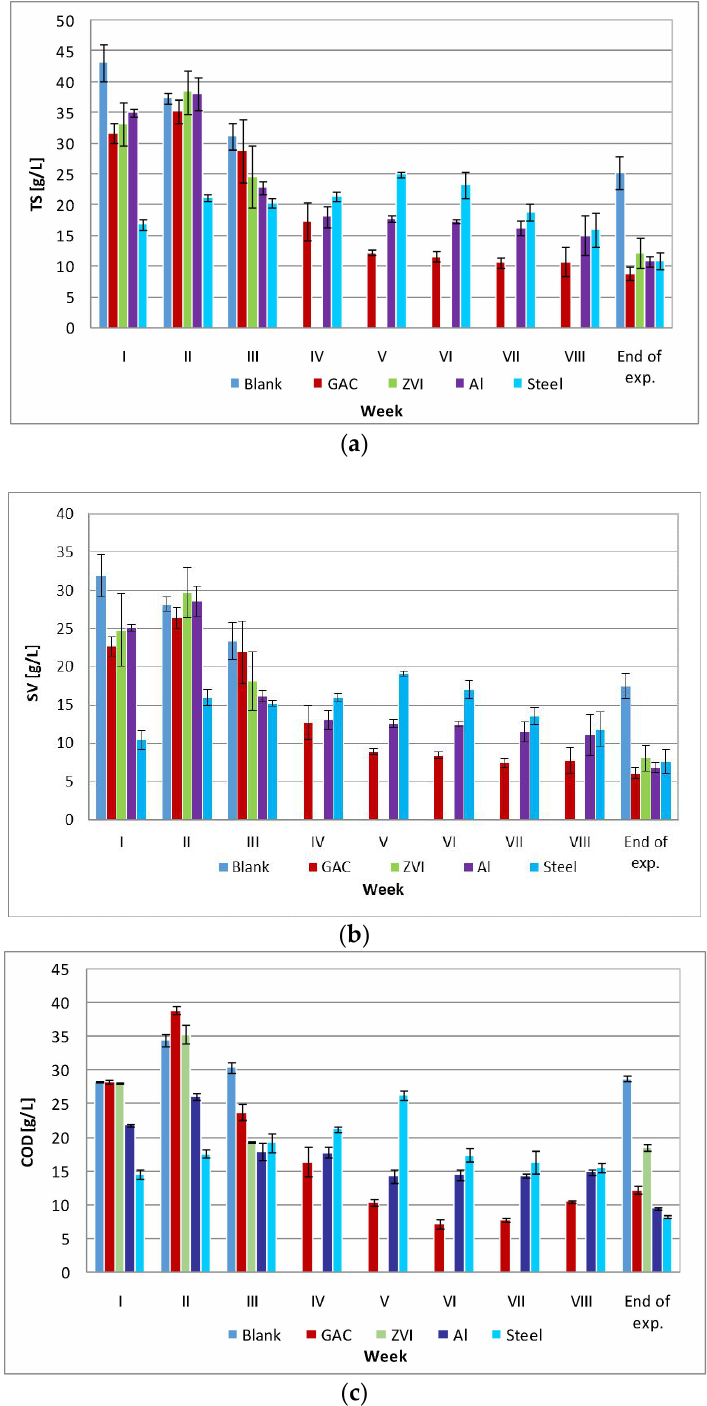
Figure 4. TS ( a ), VS ( b ), and COD ( c ) in semi-continuous tests (lacking data refer to periods where feeding was not performed and, therefore, digestate was not extracted).